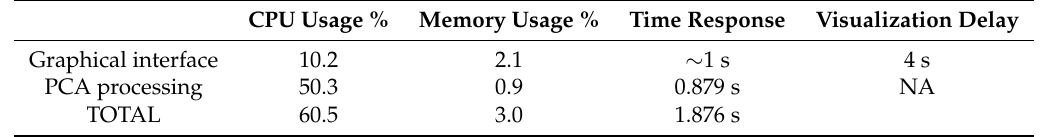
Figure 9. Components of Piezo-diagnoster hardware platform. Table 2. Average performance of Piezo-diagnoster system.